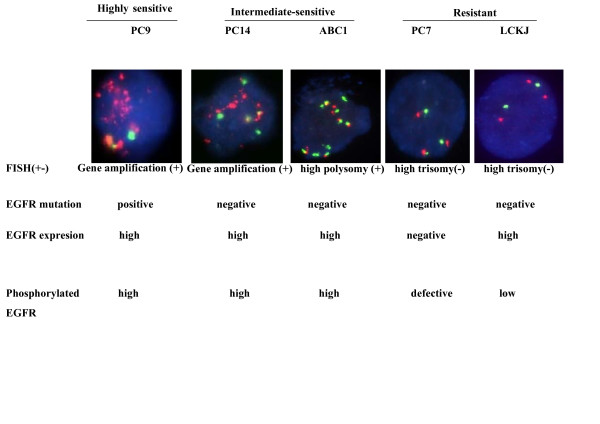
Fluorescence in situ hybridization (FISH) analyses of lung cancer cell lines, and EGFR mutations and expression. EGFR gene copy numbers were counted and were classified into six FISH strata [9,19]. EGFR gene amplification was detected in PC9 and PC14 cells. In the ABC1 cell line, the EGFR gene copy number was five in over 40% of cells (high polysomy:FISH negative); in the PC7 and LCKJ cell lines, the EGFR gene copy number was three in over 40% of cells (high trisomy:FISH negative).